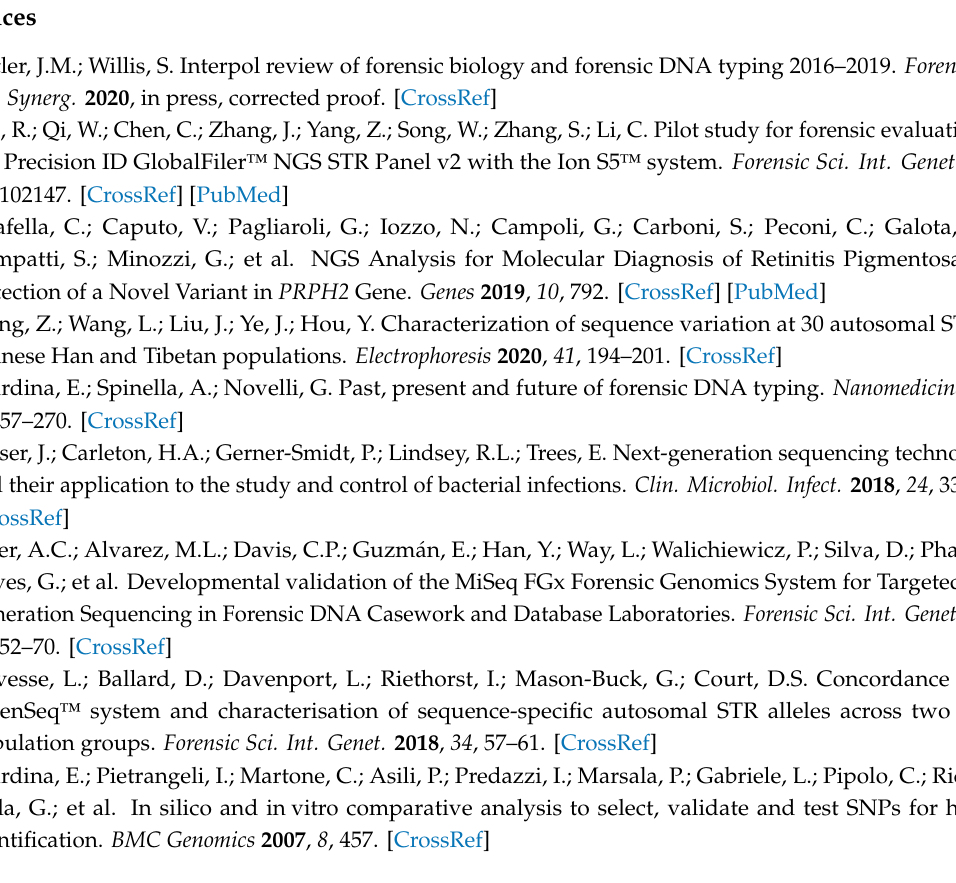
Table S1: Selected samples from 10 unrelated individuals, Table S2: Di ff erent mixtures utilized in this studio, Table S3: Loci evaluated for the comparison of the two methods, Table S4: Quantification and degradation data of buccal swab samples, Table S5 Quantification and degradation data of urine samples, Table S6: Genotyping results for the 23 loci by mean of CE methodology regarding samples from buccal swabs. CE: Capillary Electrophoresis, Table S7: Genotyping results for the 23 loci by mean of NGS methodology regarding samples from buccal swabs. NGS: Next Generation Sequencing, Table S8: Genotyping results for the 23 loci by mean of CE methodology regarding samples from urine. CE: Capillary Electrophoresis, Table S9: Genotyping results for the 23 loci by mean of NGS methodology regarding samples from urine. NGS: Next Generation Sequencing, Table S10: The mixture samples DNA